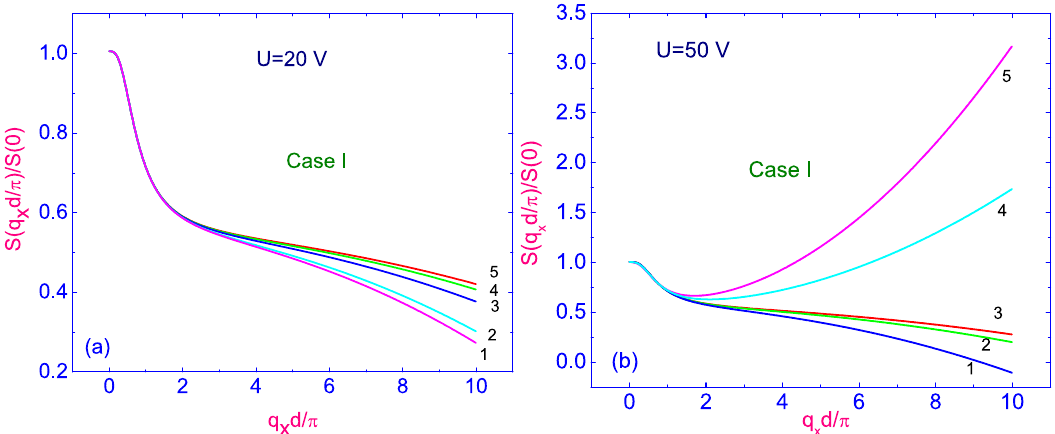
Figure 5. Plot of the dimensionless growth rate s ( q x d / π ) / s ( 0 ) vs. dimensionless wavelength q x d / π for a number of values of the voltage ( a ) U = 20 V and ( b ) U = 50 V [18], and for a number of values of the angle α : 0.157 ( ∼ 9 ◦ ) (curve (1)); 0.471 ( ∼ 27 ◦ ) (curve (2)); 0.785 ( ∼ 45 ◦ ) (curve (3)); 1.257 ( ∼ 72 ◦ ) (curve (4)), and 1.57 ( ∼ 90 ◦ ) (curve (5)),